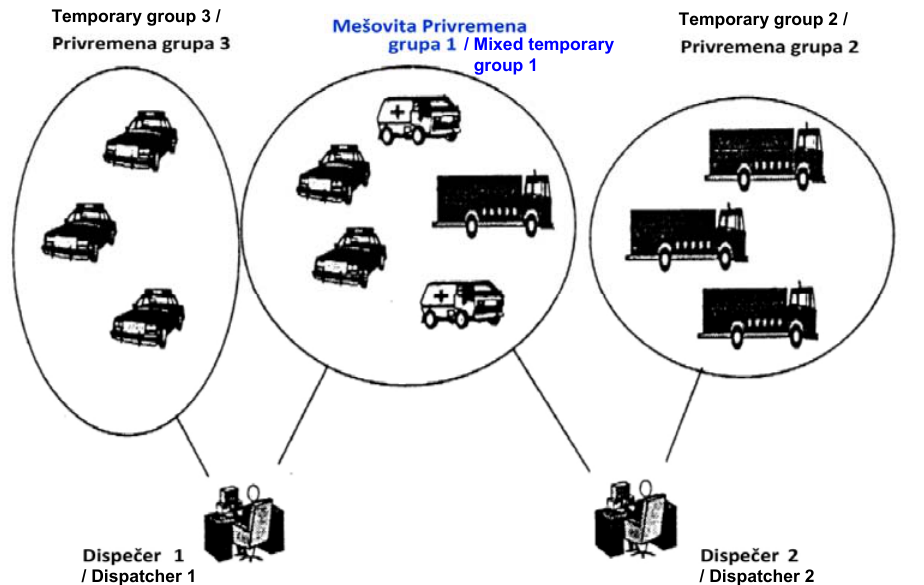
Figure 10 – Overview of the formation of a special-temporary mixed functional group of users in the event of an accident within a single TETRA 1 network (123seminarsonly,